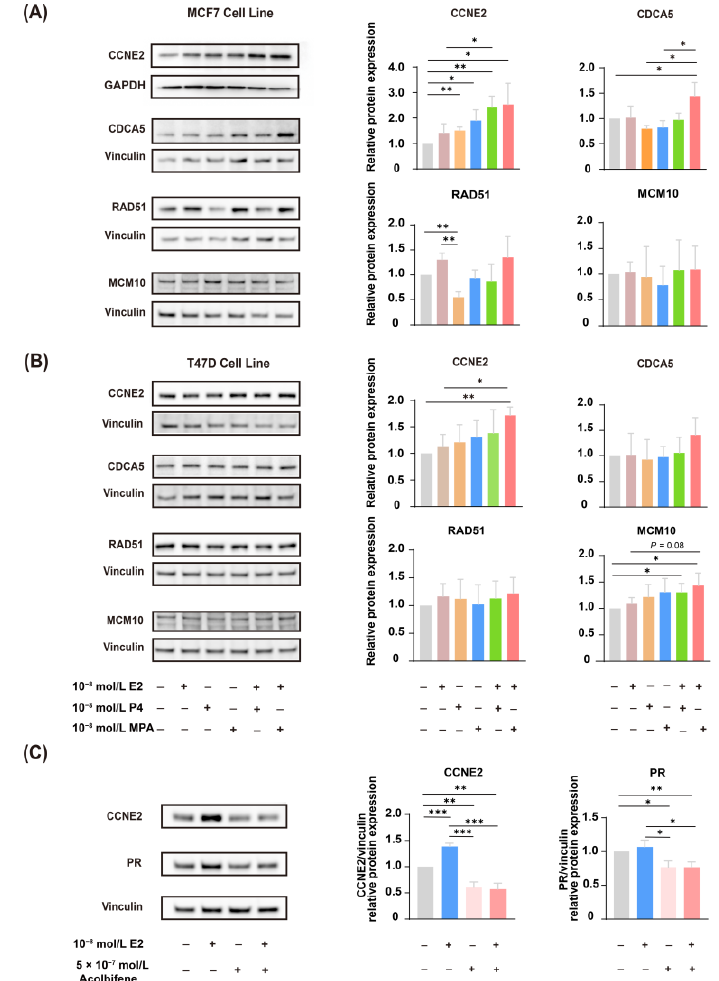
Figure 7. The expression of CCNE2 is correlated with estrogen and progestogen. ( A ) Western blotting analysis validated the expression of CCNE2, CDCA5, RAD51, and MCM10 in MCF-7 human breast cancer cells. The ethanol treatment is used as a control. ( B ) Western blotting analysis validated the expression of CCNE2, CDCA5, RAD51, and MCM10 in T47D human breast cancer cells. The ethanol treatment is used as a control. ( C ) Acolbifene (EM-652) attenuates the expression of CCNE2. Acolbifene, an estrogen receptor antagonist, was used to block the effects of estrogen through ER. T47D cells were treated with 10 − 8 E2 for 16h with or without pretreatment with acolbifene for 24 h. The DMSO treatment was used as a control. The data are normalized to the control group. Statistical significance is indicated: * p < 0.05, ** p < 0.01, and *** p < 0.001. E2, 17 β -estradiol; P4, progesterone; MPA, medroxyprogesterone acetate; ER, estrogen receptor; PR, progesterone